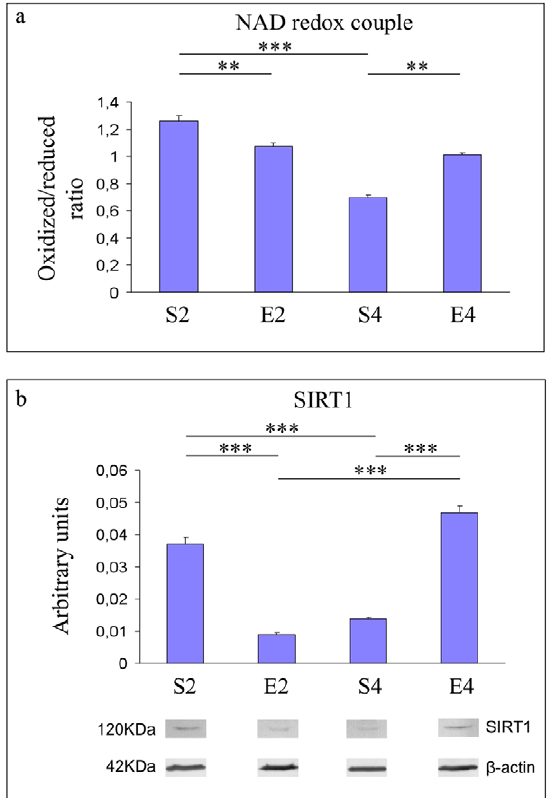
Figure 7. NAD redox balance and expression of SIRT1 in hippocampi of mice undergoing 2- or 4-mo moderate treadmill running. Assessment of nicotinamide adenine dinucleotide redox balance (panel a) and Western immunoblot against SIRT1 (panel b) in hippocampi of mature CD-1 female mice undergoing a two- or four- month moderate and regular treadmill-based exercise program (E2 or E4, respectively); age-matched sedentary animals (S2, S4) were used as controls (n=12 per group). Both the NAD redox ratio and the SIRT1 protein level were decreased in an age-dependent fashion (S4 vs S2) (panels a and b, respectively). 2-mo exercise reduced both the NAD + / NADH ratio and the expression level of SIRT1 (E2 vs S2) (panels a and b, respectively), whereas both the NAD redox balance and the protein level of SIRT1 increased after 4-mo exercise (E4 vs S4) (panels a and b, respectively). Western blot signals were normalized against the housekeeping b -actin. Representative western immunoblots of three independent experiments were reported in panel b. Values were given as means 6 std. dev. The level of statistical significance was computed by using two-way ANOVA and post-hoc Newman-Keuls test: *** P , 0.001; ** P , 0.01. Experiments were performed in triplicate. (BSA) as the standard [59]. Denaturated samples (25 m g total proteins) were run through polyacrylamide denaturing gels (12– 15%) and bands were transferred onto methanol-activated polyvinylidene fluoride (PVDF) sheets by wet electrophoretic transfer [60,61]. Non-specific binding sites were blocked with 5% (w/v) non-fat dry milk in Tris-buffered saline containing 0.05% (v/v) Tween 20 (TBS–T) for 1 h. Then, membranes were incubated with TBS-T containing primary rabbit polyclonal antibodies overnight at 4 u C, with the following dilution conditions: anti-GLO1 (1:400), anti-SIRT1 (1:200), anti- b -actin (1:1000). PVDF sheets were washed 3 times with TBS-T (5 min each) and incubated with a horseradish peroxidase (HRP)-conjugated secondary anti-rabbit antibody (dil. 1:2,000) for 2 h. Membranes